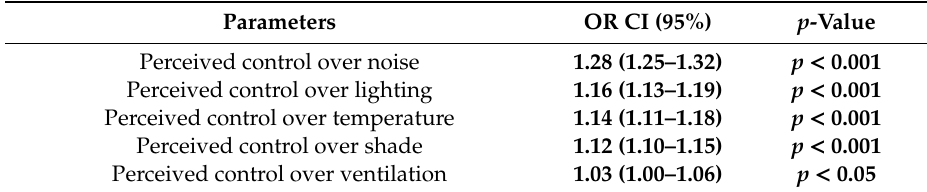
Table 7. Relations between perceived control and perceived overall